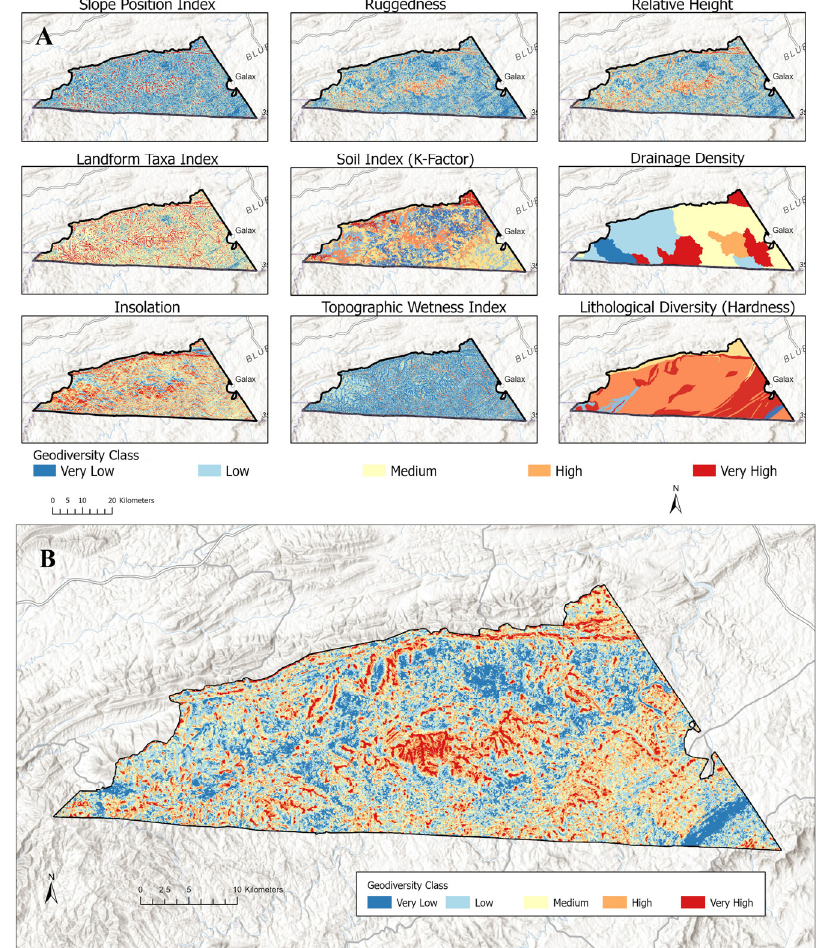
Figure 4. Nine geologic and geomorphological factors ( A ) were integrated into the final geodiversity map for Grayson County, Virginia ( B ). The final geodiversity raster map had geodiversity ranging from 85.6 to 480.4, which were grouped into five classes: very low (85.60–224.94), low (224.95–265.19), medium (265.20–305.44), high (305.45–359.63), and very high (359.64–480.40) using natural breaks [51].